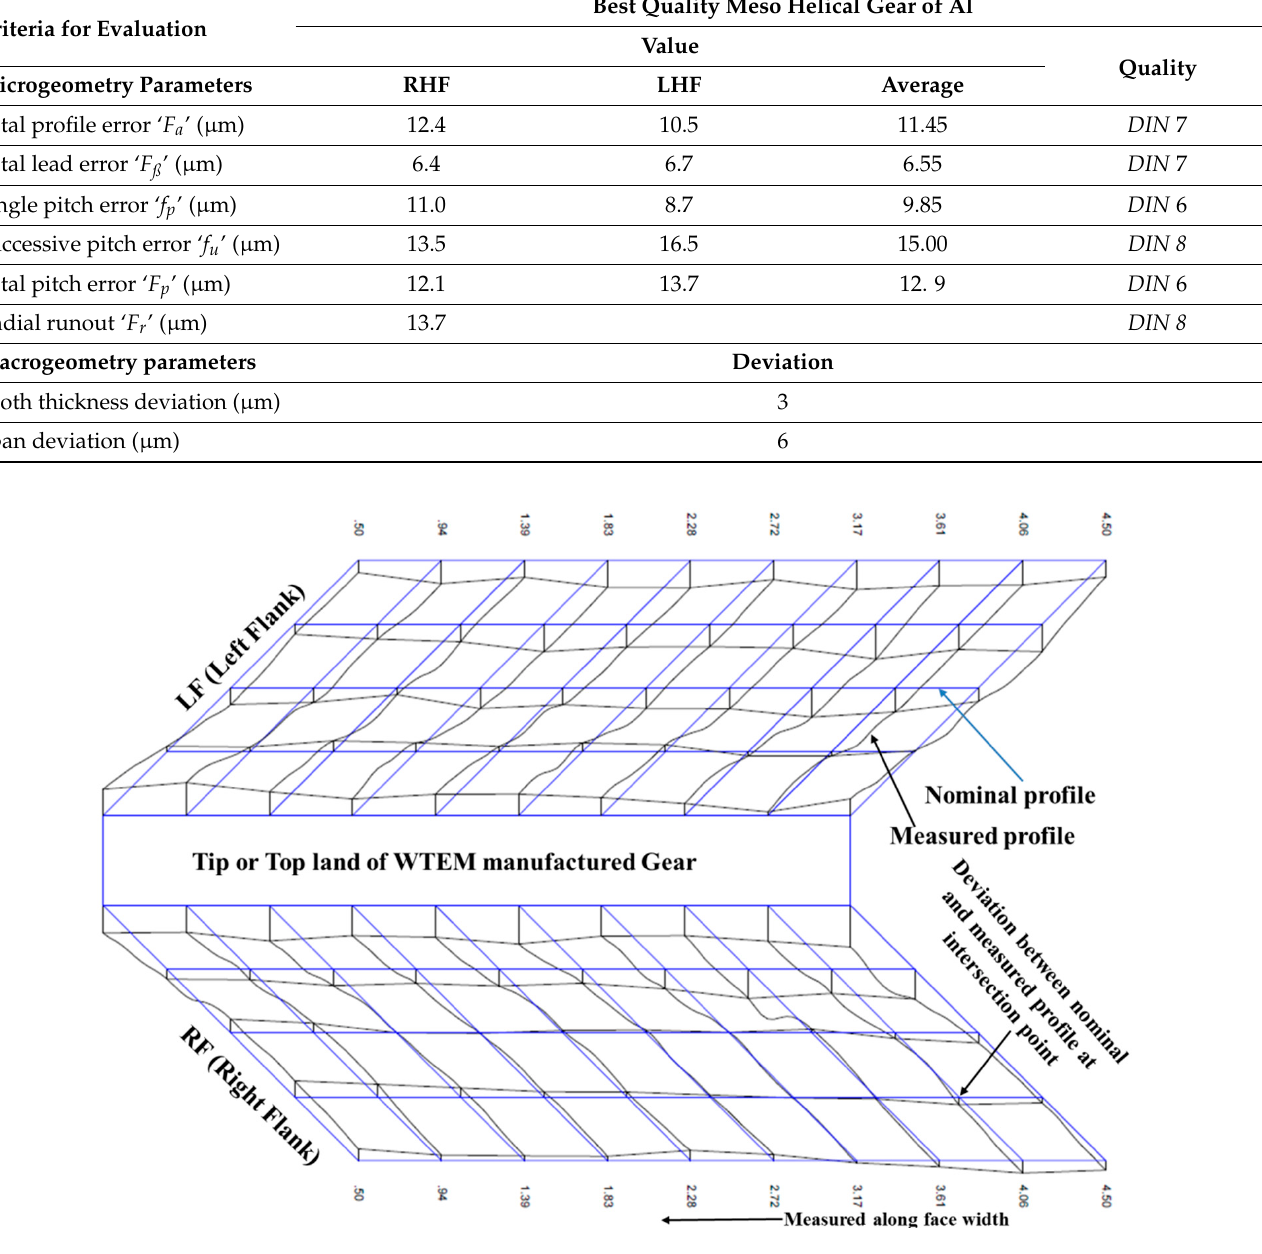
Figure 9. Topography of miniature gear manufactured using optimized machining parameters.